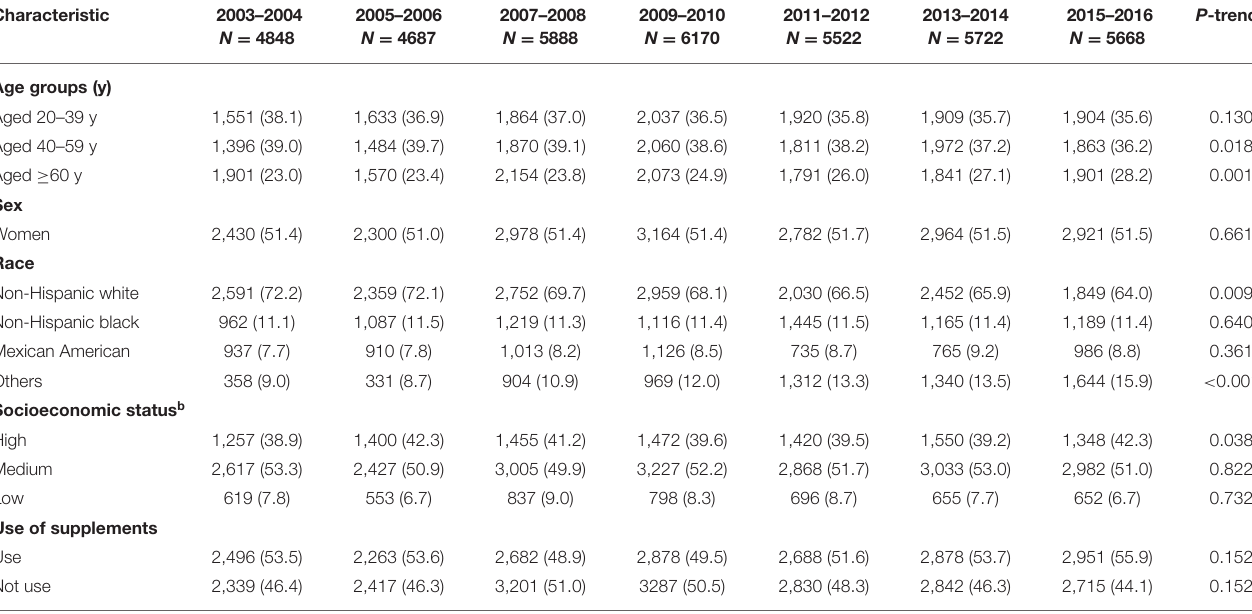
TABLE 1 | Characteristics of study participants in the National Health and Nutrition Examination Survey (2003–2016) a .